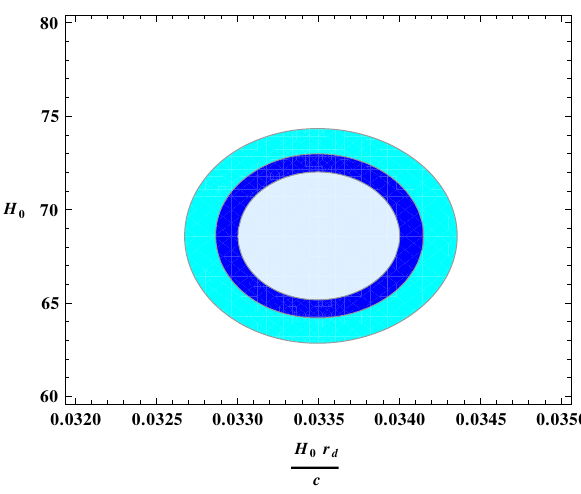
Fig. 9 Observational constraints on the parameters space ( H 0 r d / c − H 0 ) at the 68.3% (light blue), 90% (dark blue) and 99% (cyan) confi- dence levels